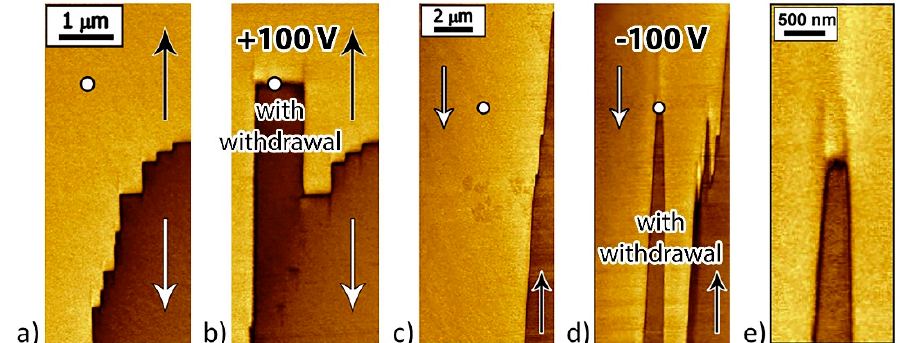
Figure 10. PFM images of written domains in the vicinity of as-grown domain wall with probe withdrawal. PFM domain images: ( a,c ) Before and ( b,d ) after local polarization reversal by a voltage with ( b ) positive and ( d ) negative pulses. ( e ) Zigzag-shaped head-to-head charged domain wall formed by local polarization reversal. The arrows indicate the spontaneous polarization directions.